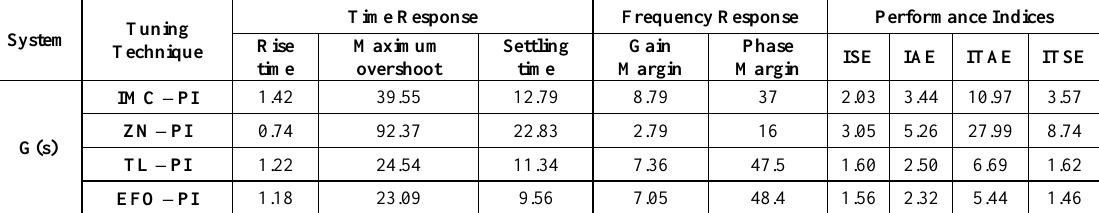
Table 6. Closed loop PI - controlled responses of G(s)